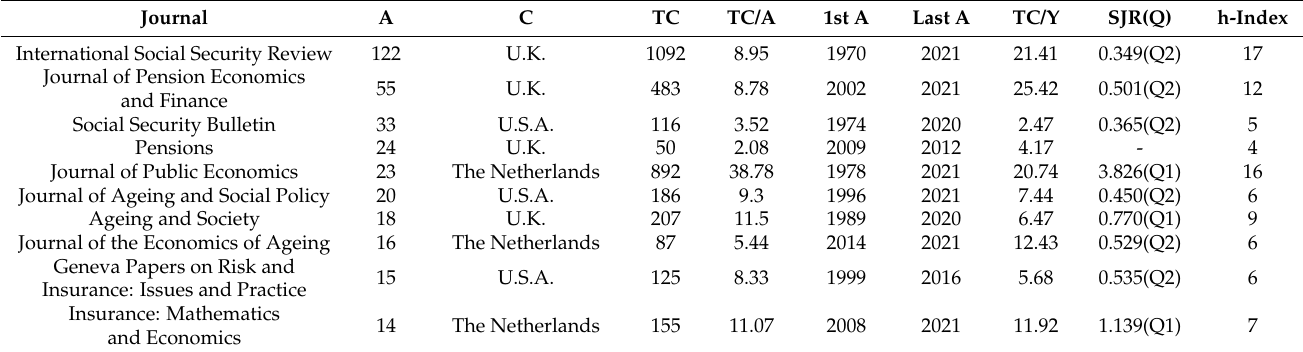
Table 3. The top 10 most productive journals on pension research.